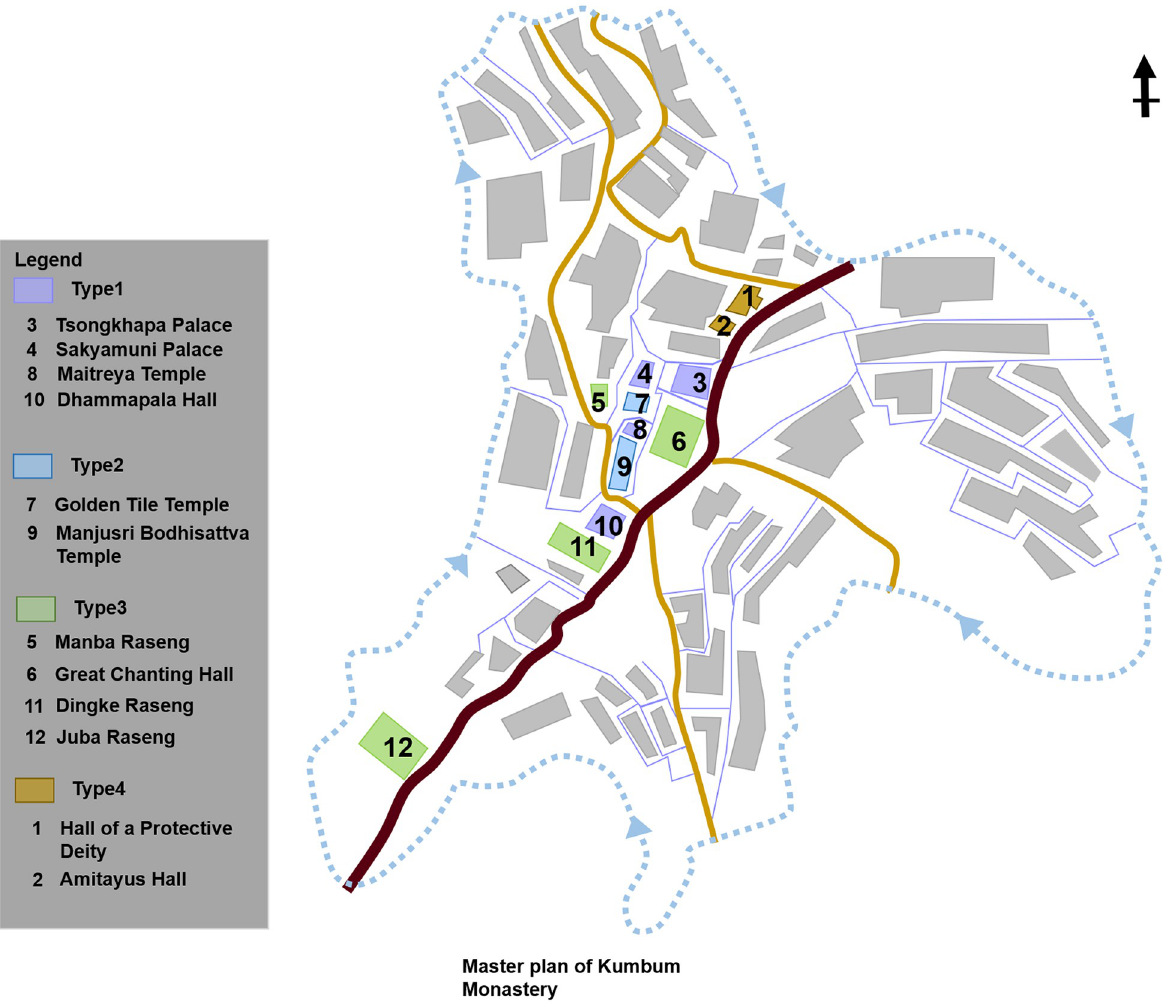
Fig 14. Distribution of 4 types of palace buildings in Kumbum